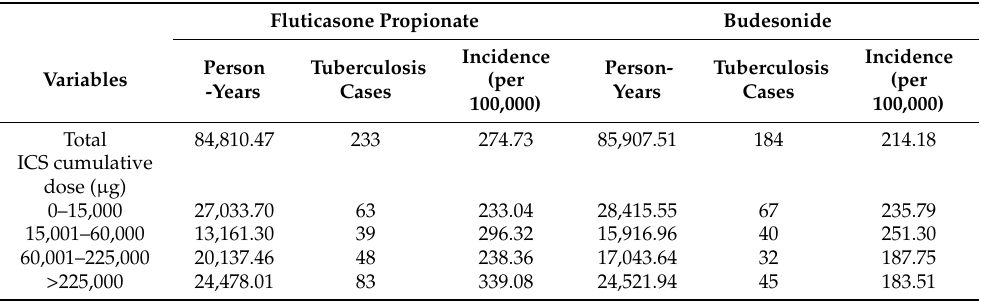
Table 3. Crude incidence rate of tuberculosis according to the ICS components and cumulative